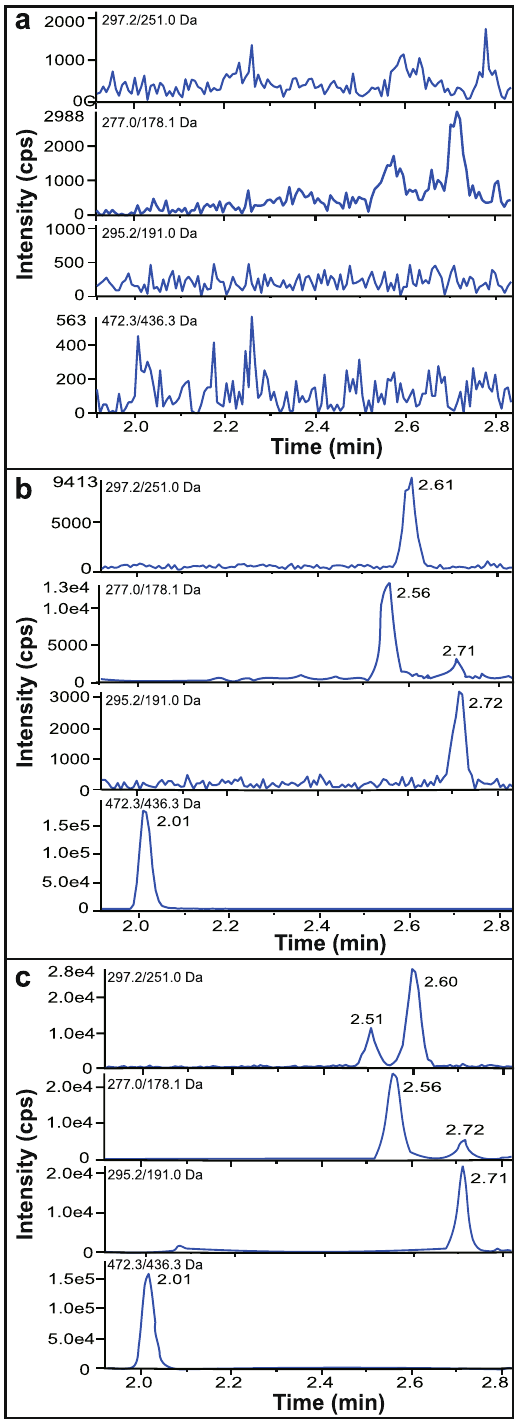
Figure 2. Representative multiple reaction monitoring (MRM) chromatograms of cryptotanshinone (CTS), tanshinone I (TSI), tanshinone IIA (TSA) and terfenadine (IS) in blank plasma ( a ), plasma spiked with tanshinones at LLOQ and IS ( b ), and plasma sample collected at 8 h after dosage ( c